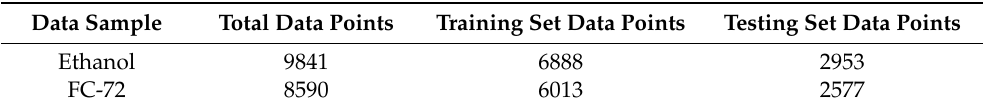
Table 4. Split of data samples for ethanol and